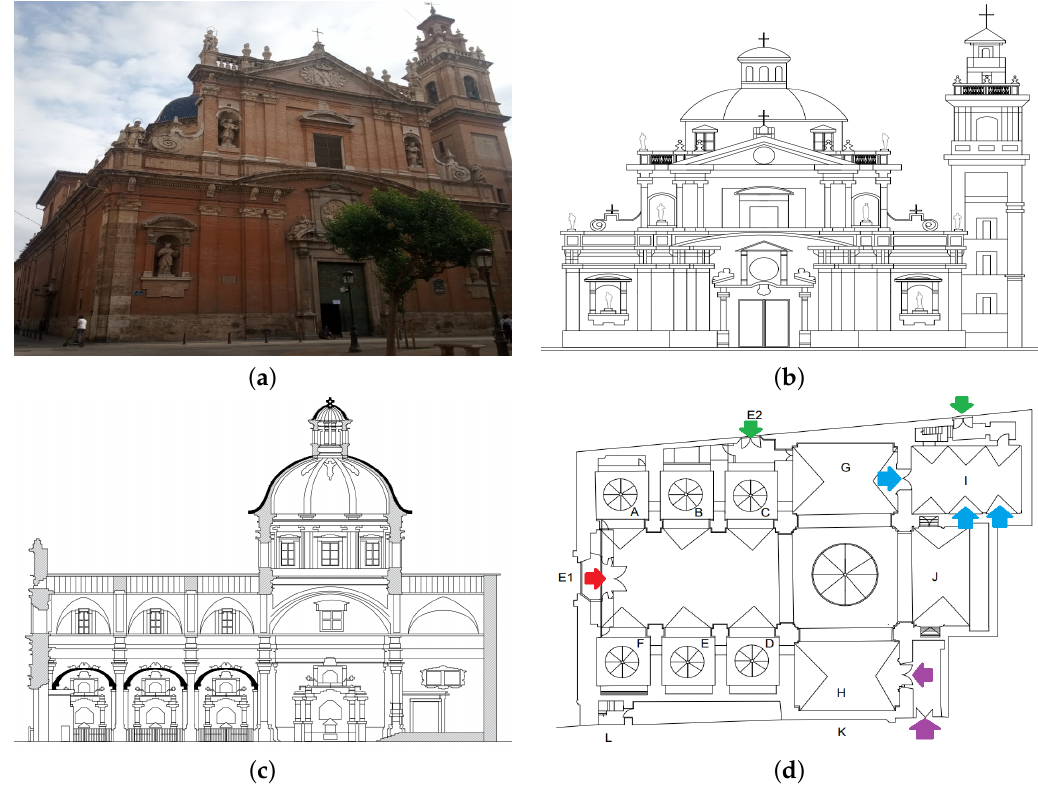
Figure 1. Church of Saint Thomas the Apostle and Saint Philip Neri in Valencia (Spain). ( a ) Front and side view of the church; ( b ) front view; ( c ) longitudinal section; ( d ) plan of the church, where the different observable structures are indicated: A.